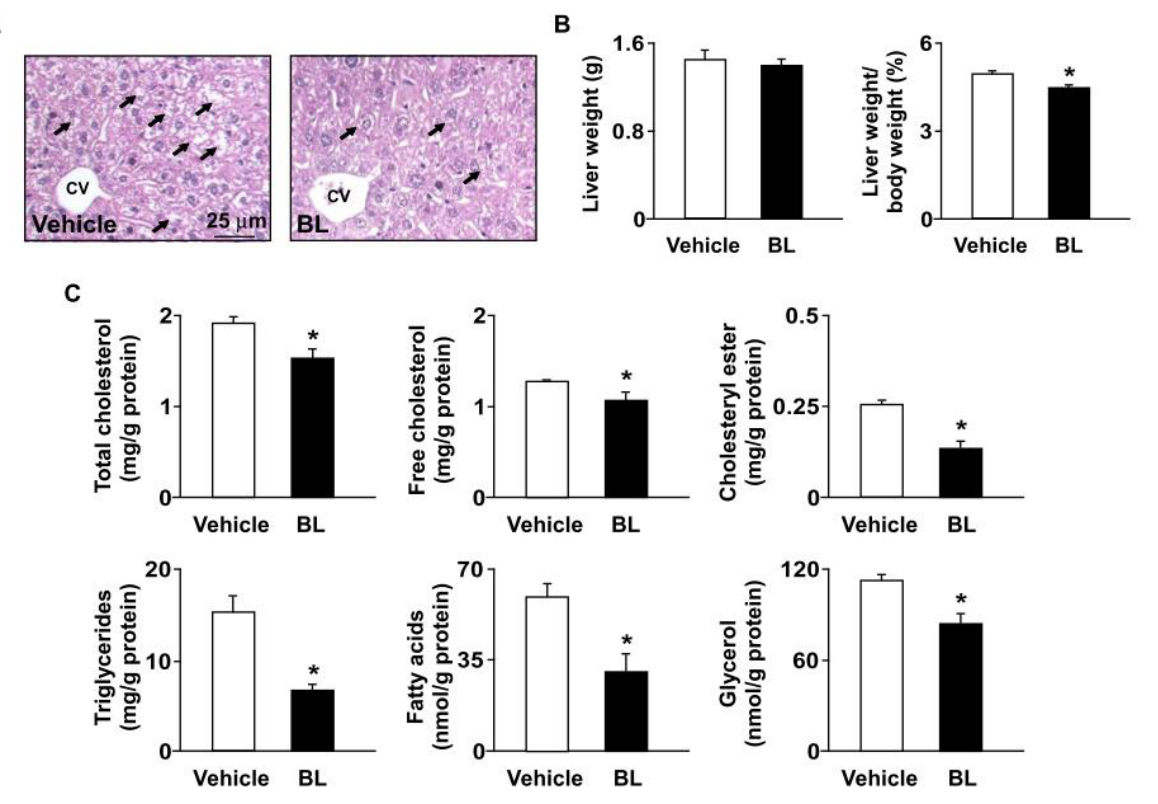
Figure 4. Bromelain reduces lipid accumulation in the livers of apoe − / − mice. Male apoe − / − mice were orally administered bromelain (BL, 20 mg/kg/day) or vehicle (PBS) for four weeks. ( A ) Representative images of H&E staining in bromelain- or vehicle-treated apoe − / − mice. Scale bar = 25 µ m. CV: central vein. The foamy hepatocytes were indicated by arrows. ( B ) The liver weight and the ratio of liver weight to body weight. ( C ) The hepatic levels of total cholesterol, free cholesterol, cholesteryl ester, triglycerides, fatty acids, and glycerol. * p < 0.05 vs. vehicle-treated apoe − / − mice.